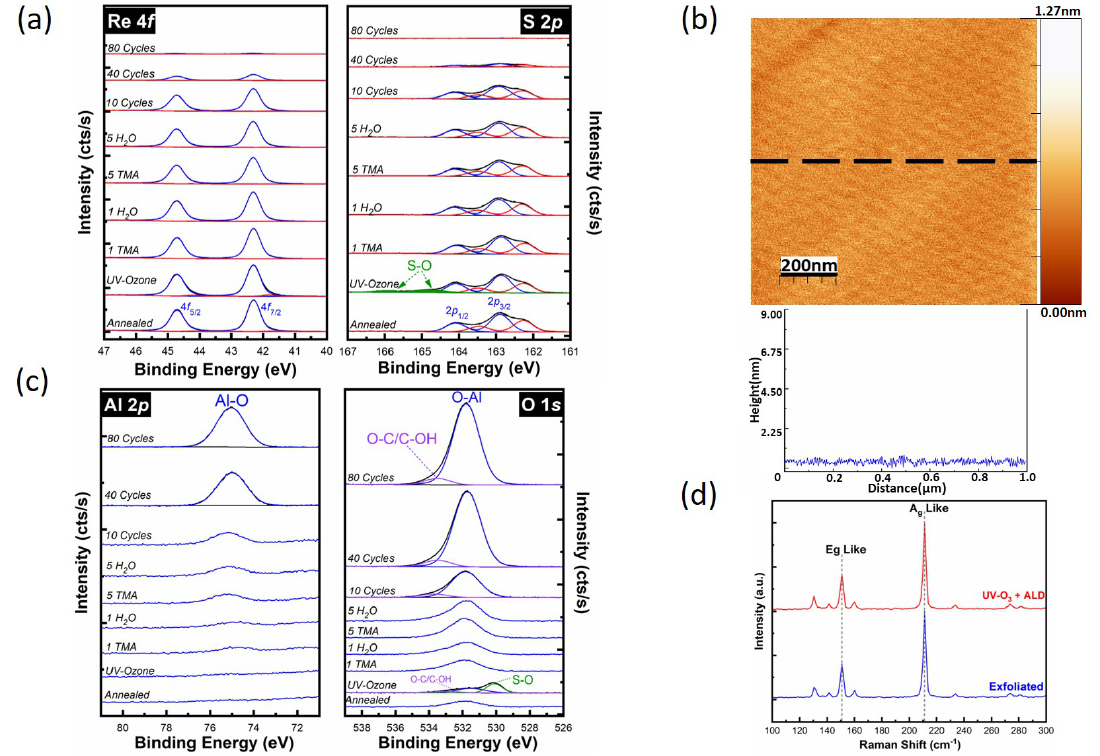
Figure 4. Deposition of Al 2 O 3 using thermal ALD on functionalized ReS 2 surface by UV-Ozone exposure. ( a ) The evolution of Re 4 f and S 2 p core level spectra, ( b ) Ex-situ AFM image and line profile recorded following 80 cycles PEALD of Al 2 O 3 , ( c ) Al 2 p and O 1 s core level spectra up to 80 cycles of Al 2 O 3 , and ( d ) Raman spectra from exfoliated ReS 2 and after 80 cycles of Al 2 O 3 on UV-Ozone treated ReS 2